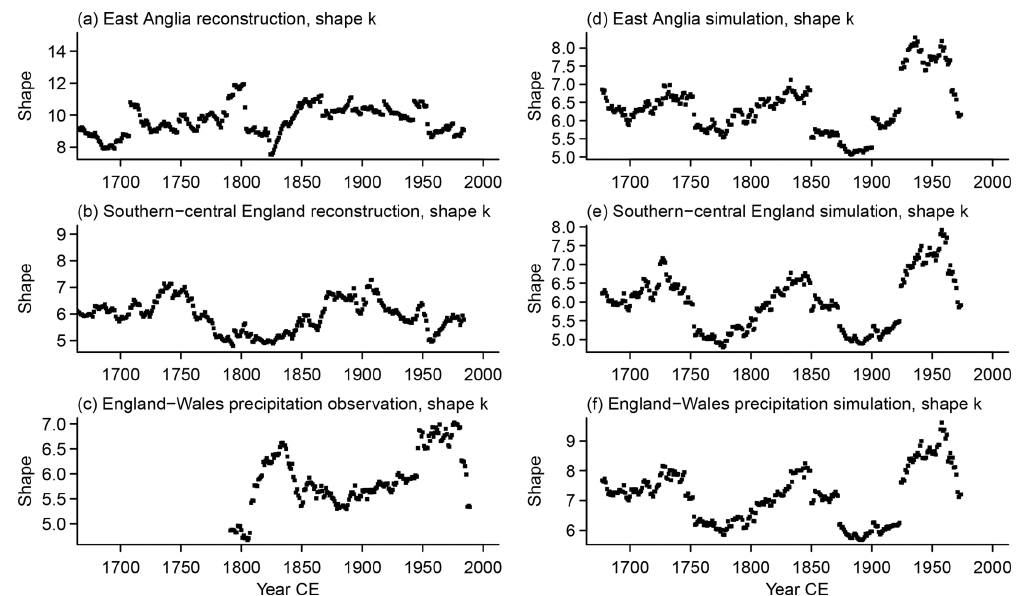
Figure C1. Evolution of the shape parameter k for the Weibull distribution fits for the (a) East Anglia reconstruction, (b) southern–central England reconstruction, (c) England–Wales precipitation observational data, (d) East Anglia regional simulation, (e) southern–central Eng- land regional simulation, and (f) England–Wales precipitation regional